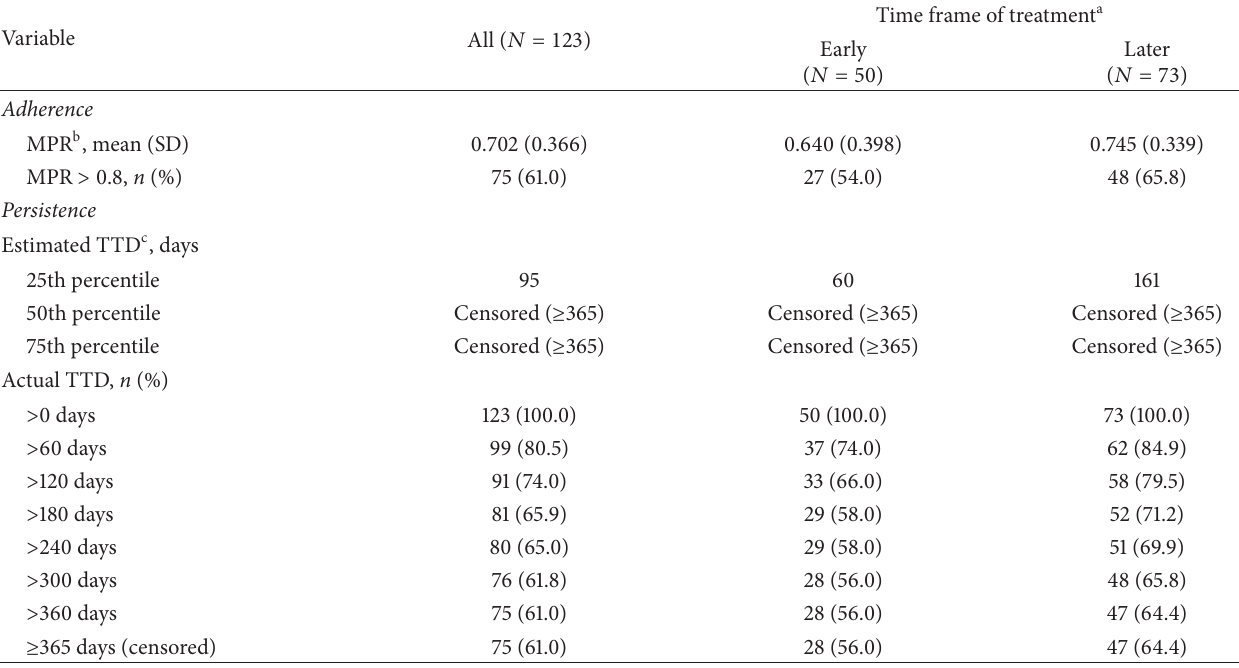
Table 2: Adherence and persistence with once-daily teriparatide during the 12-month study